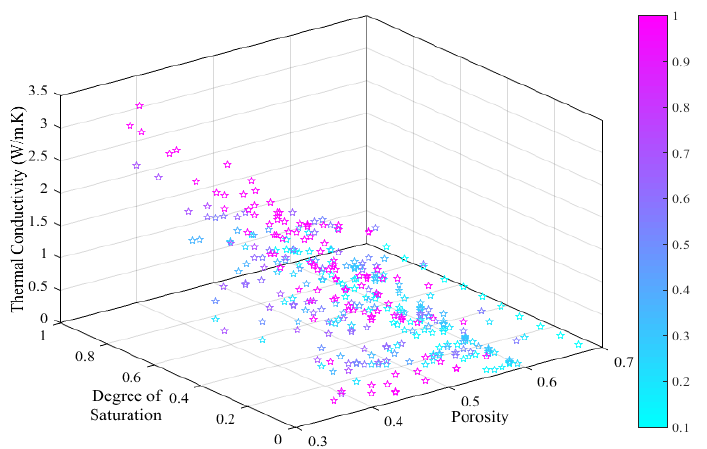
Figure 1. The thermal conductivity database with varying degrees of saturation and porosity used for training, testing and validation of models. The variation in quartz content of the sample is shown with the legend colour bar ranging from 0.1 to 1.